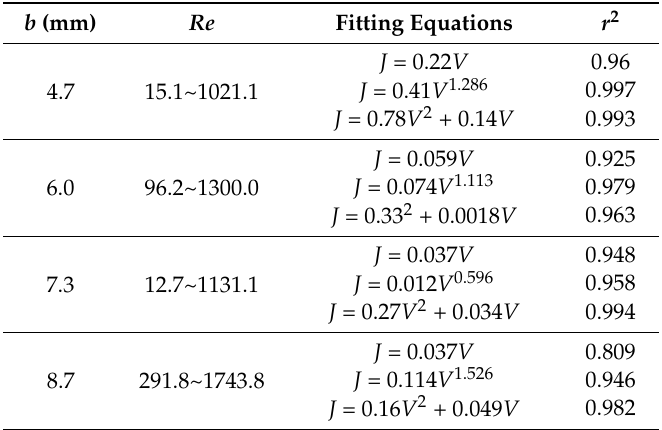
Table 4. Fitting results and goodness of fit for the V – J relationship for flow through single fractures with rectangular roughness.